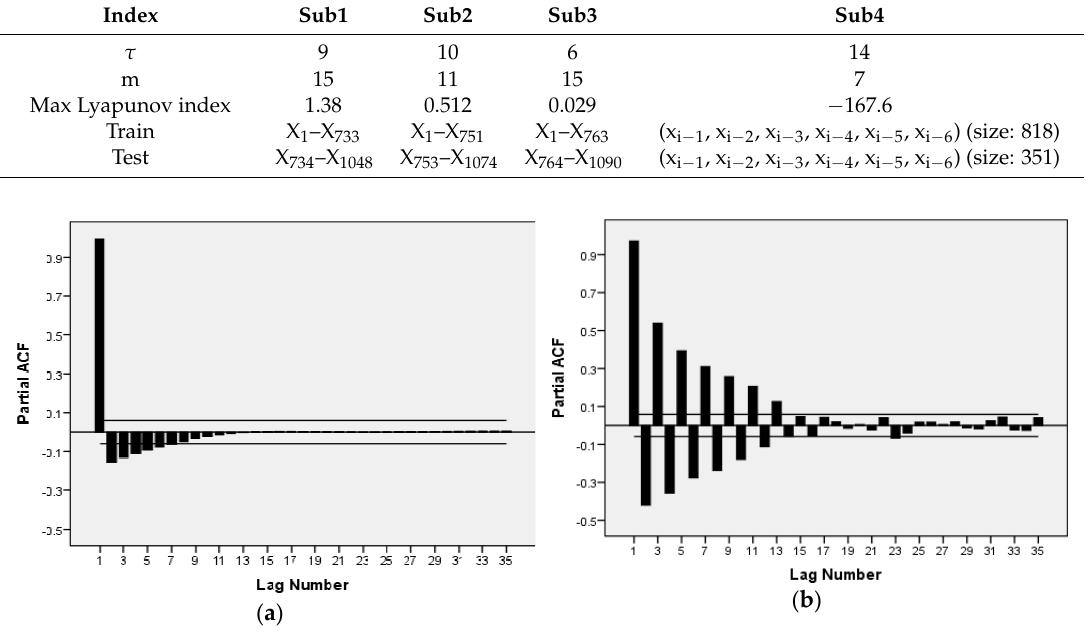
Figure 8. ( a ) The result of the partial autocorrelation function (PACF) analysis of sub4 after processing by FEEMD of the Beijing carbon price; ( b ) The result of the PACF analysis of sub5 after processing by FEEMD of the Beijing carbon price. Table 5. The parameters of each subsequence after processing by EMD-SE.